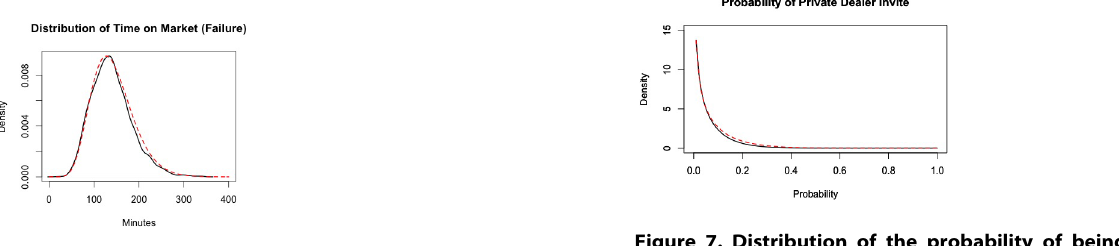
Figure 5. Distribution of time in the market, conditional on failure to obtain heroin. The black line represents the density of the amount of time each customer spent in the market for individual failed market trips based on 100 simulations of the market from days 180 to 365. The dashed red line represents a fitted distribution, which is a Gamma (9.11,0.072) distribution.